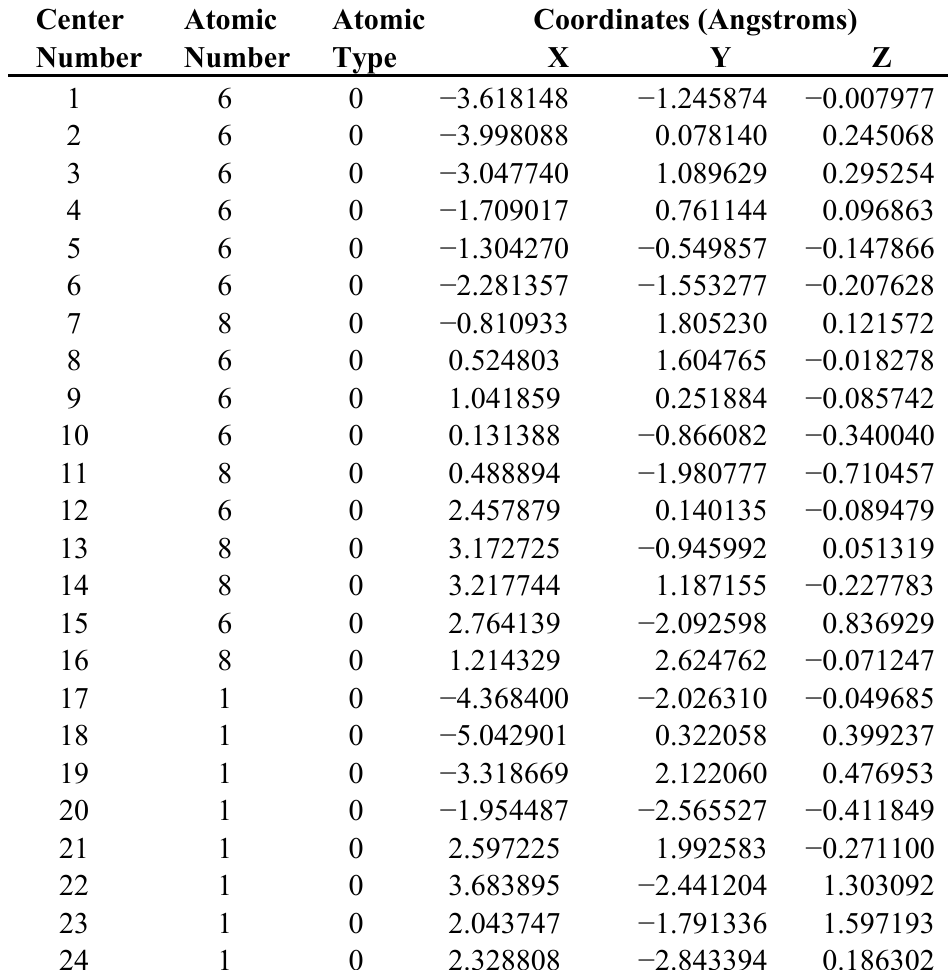
Table S2. XYZ coordinates for tautomer b.